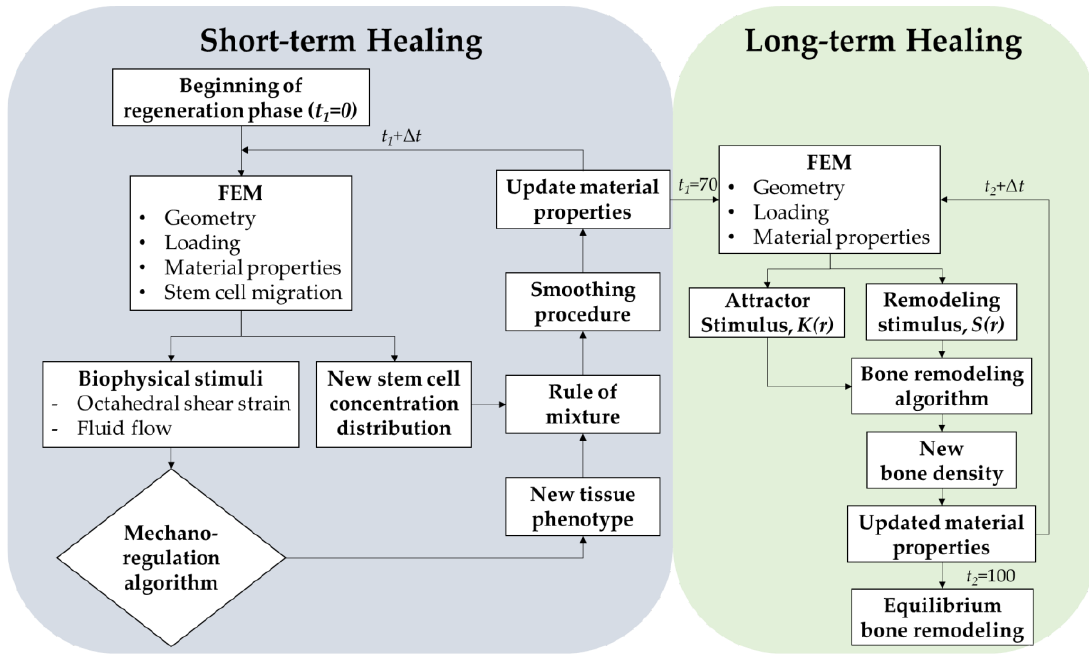
Figure 1. Flow chart of bone healing preoperative evaluation.